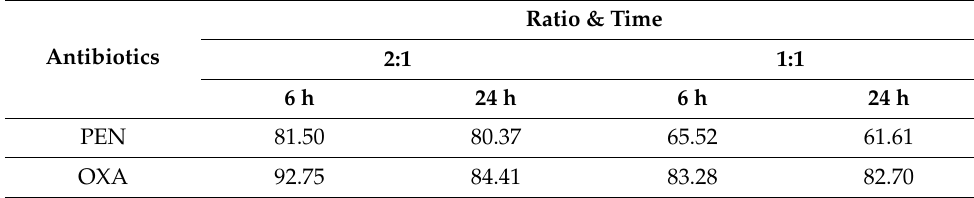
Table 1. The percentage of drug loading efficiency on GO-PEG in various